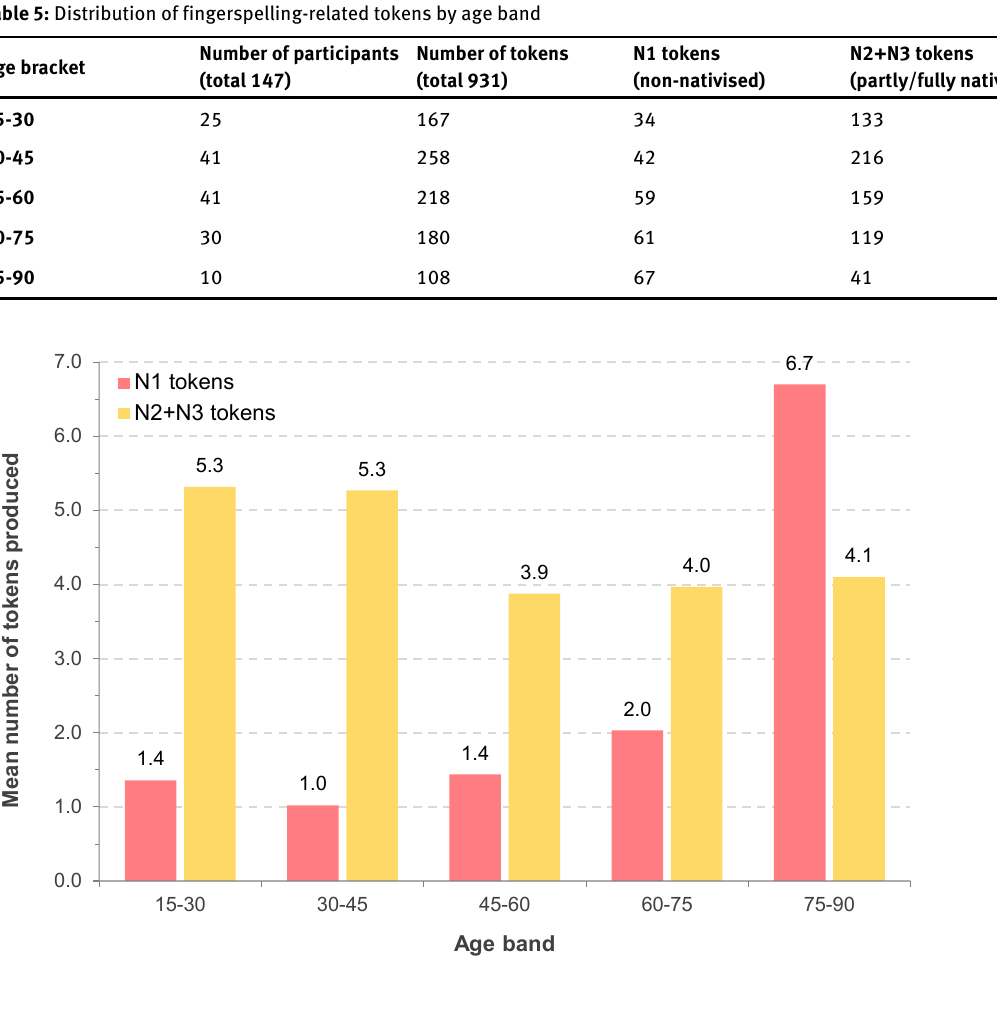
Figure 13: Mean number of N1 and N2+N3 tokens produced per participant in each age